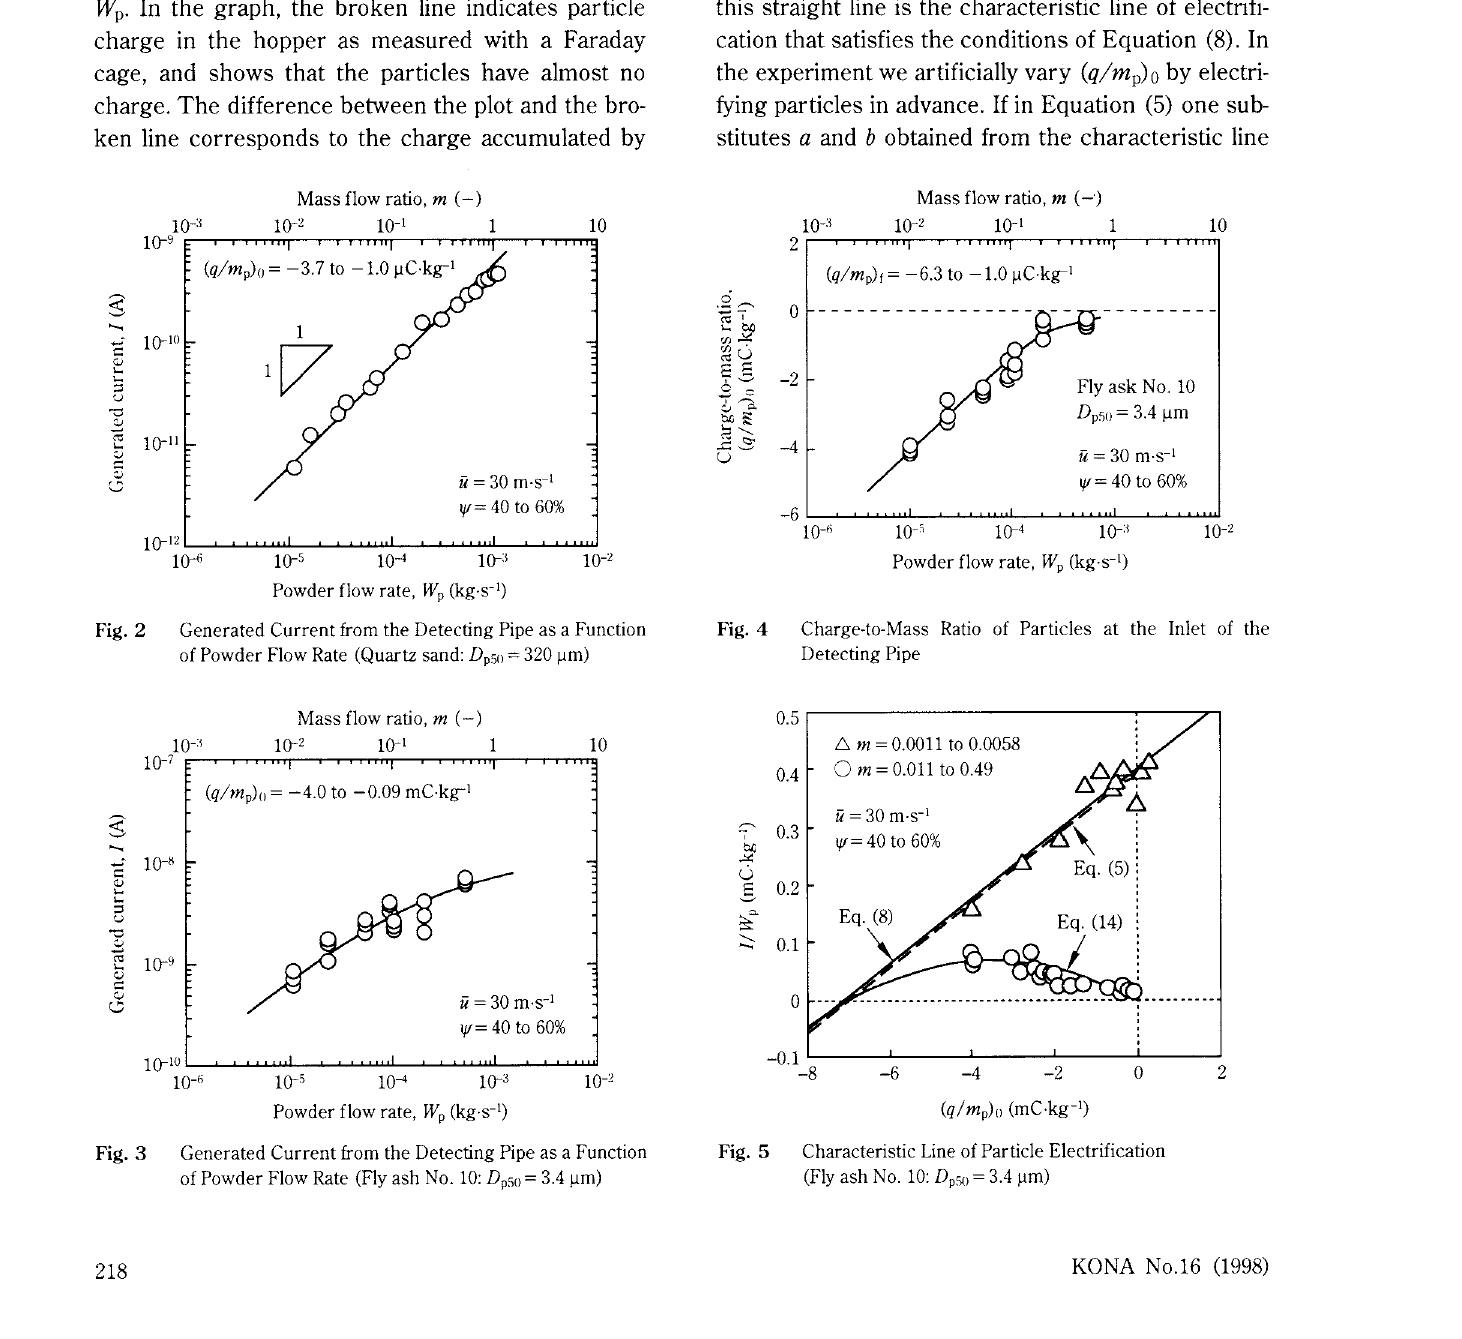
Generated Current from the Detecting Pipe as a Function of Powder Flow Rate (Fly ash No. 10: Dpso = 3.4J.lm)